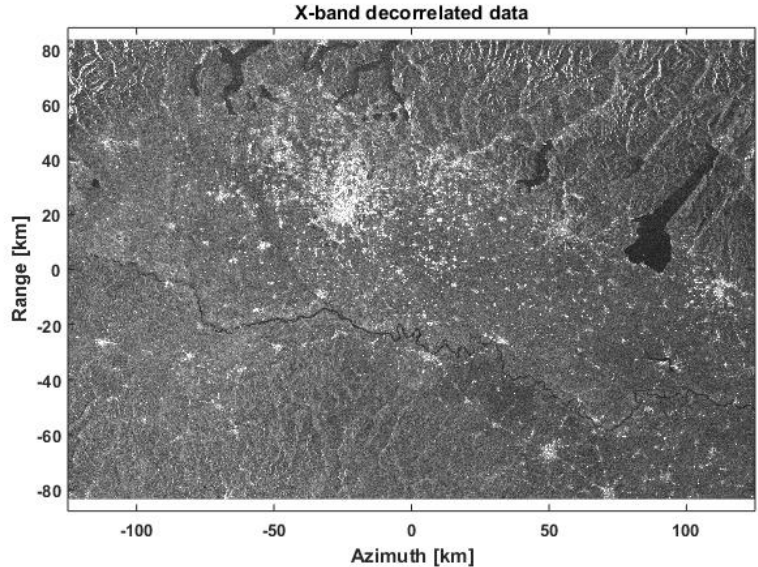
Figure 23. Simulated focused GEO SAR image in X-band with the target decorrelation effect included. The image in Figure 21 represents the reference product obtained without considering any clutter.